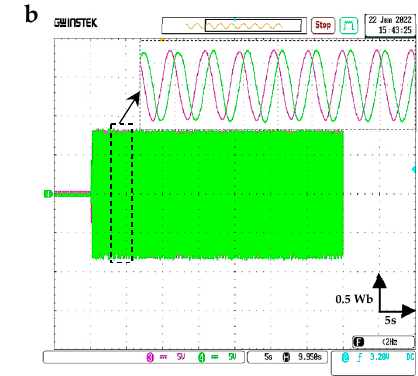
Figure 23. Rotor flux components for speed profile 1 and 2.